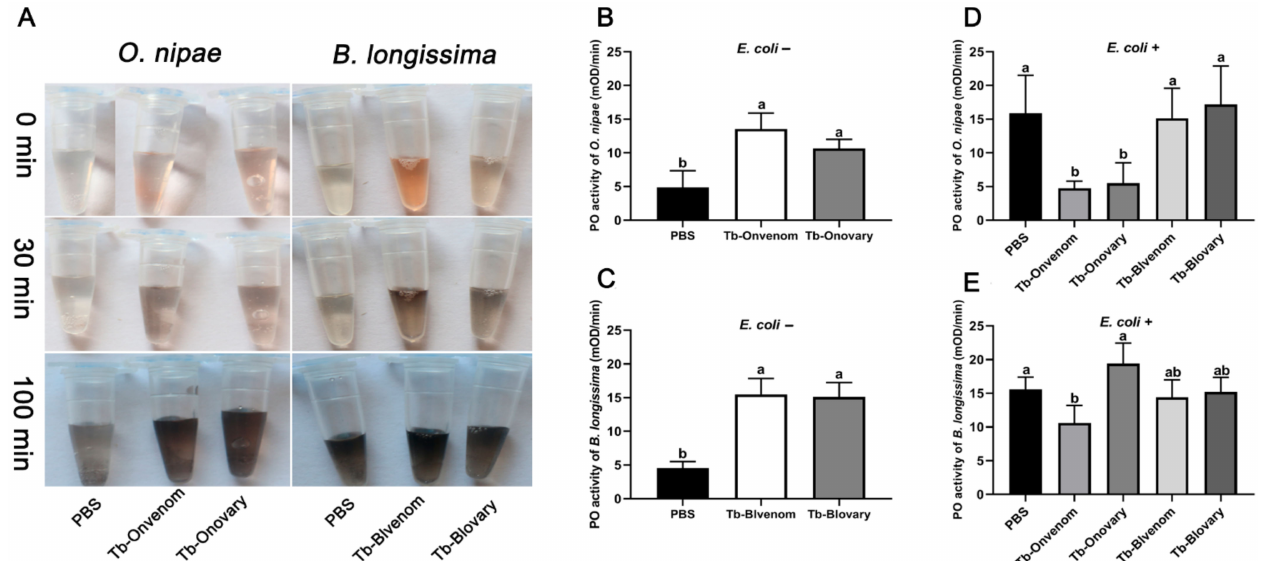
Figure 5. Effect of virulent factors on phenoloxidase (PO) activity 24 h post injection. ( A ) Melanisation of O. nipae and B. longissima haemolymph after the injection with venom or ovarian fluids. ( B , C ) PO activity of O. nipae or B. longissima haemolymph after venom and ovarian fluids injection. ( D , E ) PO activity of haemolymph collected from O. nipae or B. longissima pupae after the injection with various virulent factors and incubated with heat-inactivated E. coli for 10 min. Average V max was used to evaluate PO activity. Error bars indicate standard deviations of the mean of five independent biological replications. Different letters correspond to significant differences at the 0.05 level between different tissues (one-way ANOVA followed by Dunnett’s